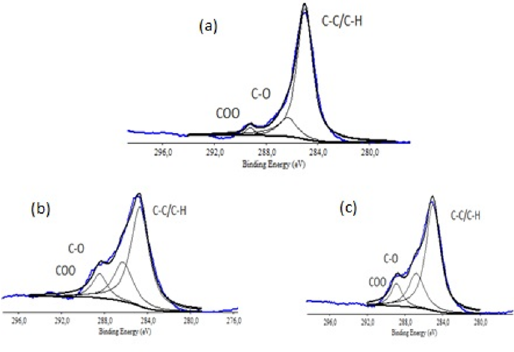
Figure 5. Deconvolution of the C1s peak of carbon for (a) untreated sample (b) front side of treated sample 40% CH side of sample treated with 40% CH